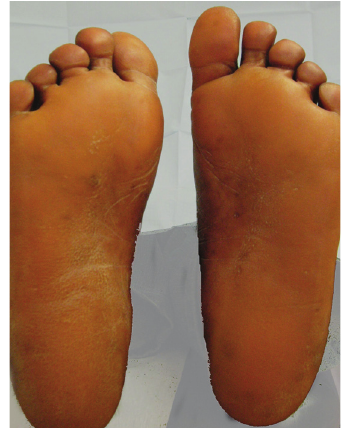
Figure 1: Di ff use plantar keratoderma, with painful fissures.